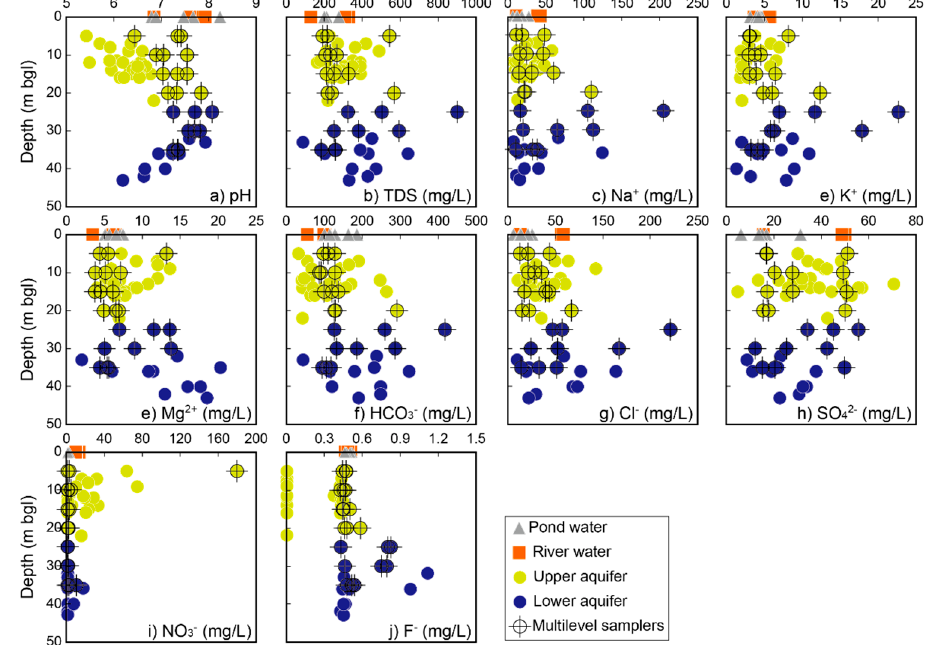
Figure 5. Vertical changes in some hydrochemical parameters with depth, showing notable differences in hydrochemistry between groundwater samples from the upper and lower aquifers. bgl = below ground level.